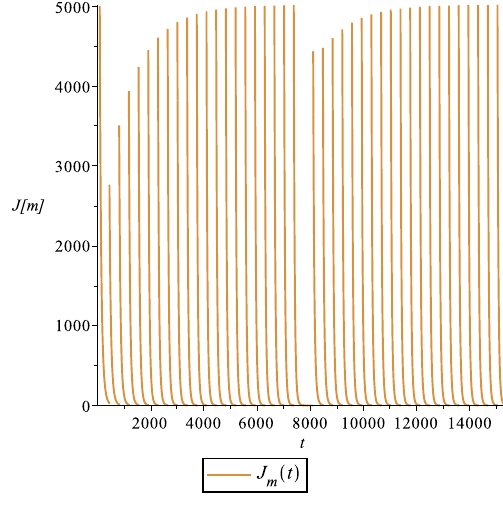
Fig. 5. Middle juveniles vs. t for 41 years